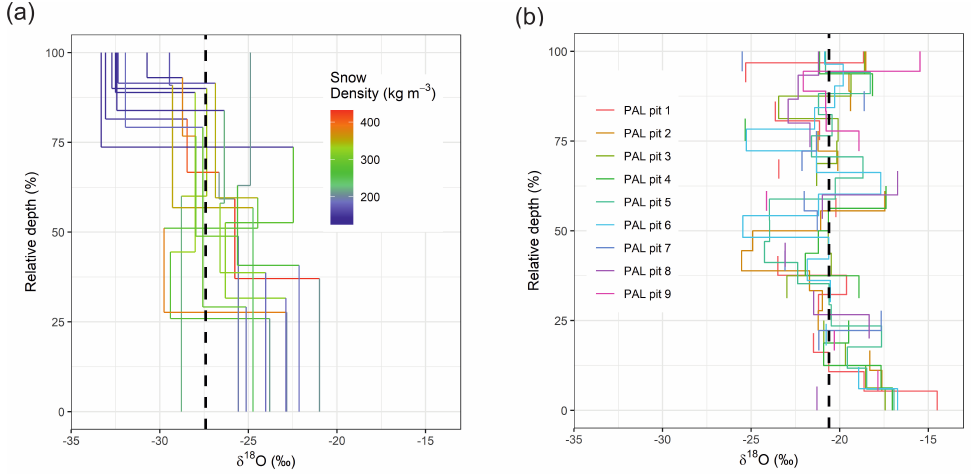
Figure 6. Snow layer δ 18 O as a function of relative depth in each snowpit for ( a ) Imnavait and ( b ) Pallas. Snow density in layers is visualized for Imnavait. Dashed line indicates the mean δ 18 O value for all samples.